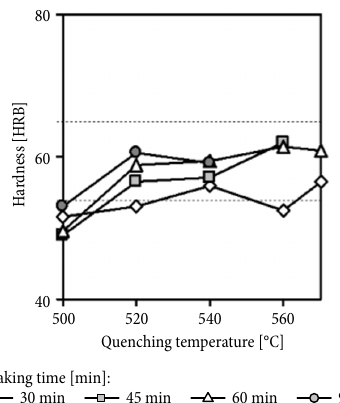
Fig. 8. Hardness of aluminium alloy 6082 after quenching from different temperatures (quenching process was followed by artificial ageing at 180 °C for 6 hours)